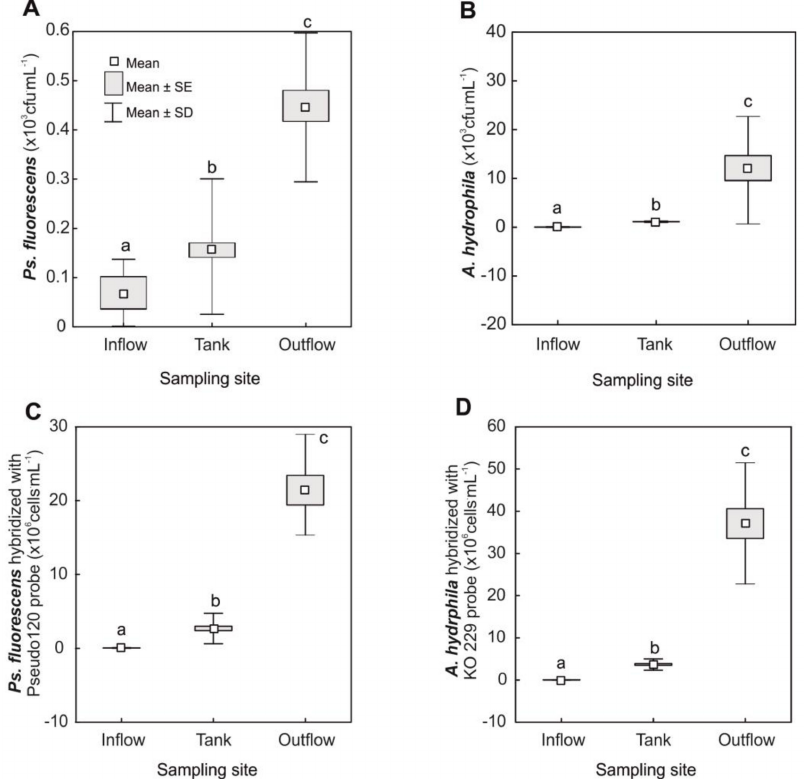
Figure 2. The counts of Pseudomonas fluorescens ( A ) and Aeromonas hydrophila bacteria ( B ) determined by a culture-dependent method and the culture-independent technique: bacteria hybridized with Pseudo120 ( C ) and KO 229 probes ( D ). The differences in the bacteria counts in water samples collected from the inflow (N = 17), tank (N = 34) and outflow (N = 17) were analyzed with the Tukey multiple comparison test (RM-ANOVA, p < 0.05). Statistically significant differences were depicted by different letters. Denotations: ± SE—standard error, ± SD—standard